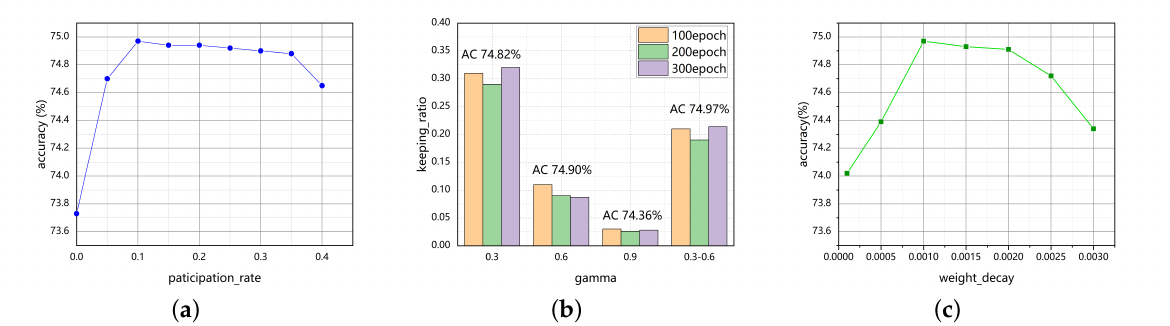
Figure 6. CIFAR100 validation accuracy against particitpation_rate, γ and weight decay with ResNet- 56 model. ( a ) participation_rate; ( b ) γ ; ( c ) weight